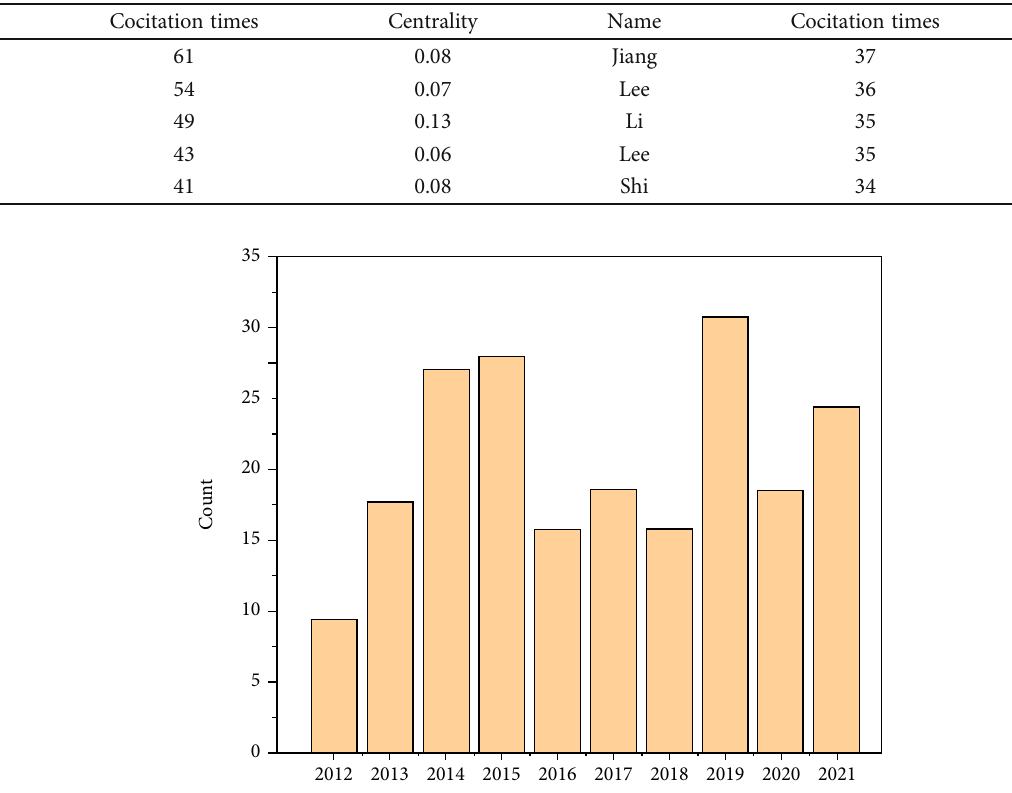
Figure 7: Annual distribution statistics visualization map of extracted